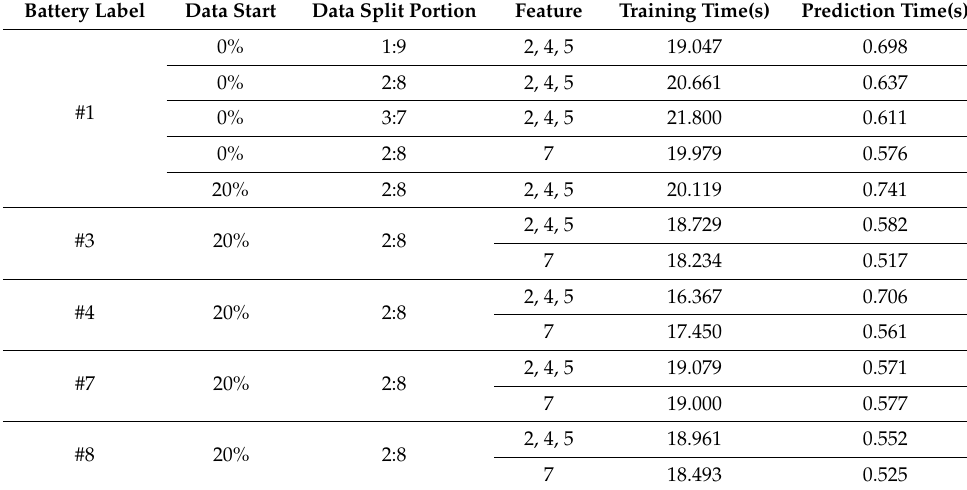
Table 4. Computation cost of training and prediction.